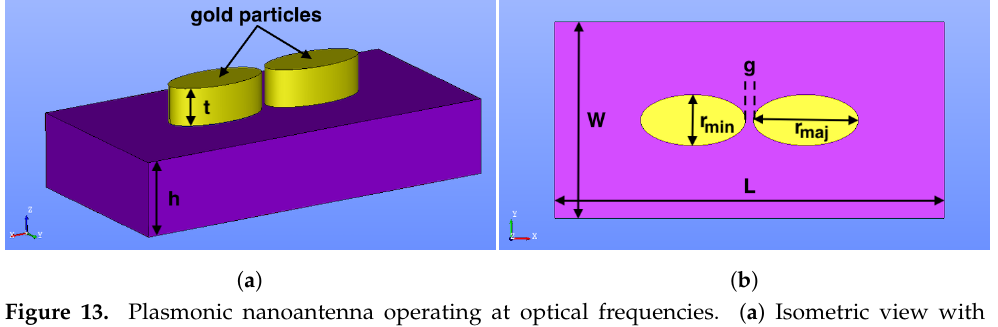
Figure 13. Plasmonic nanoantenna operating at optical frequencies. ( a ) Isometric view with h = 80 nm and t = 40 nm. ( b ) Top view with L = 400 nm, W = 200 nm, r maj = 108 nm, r min = 58 nm, and g = 28